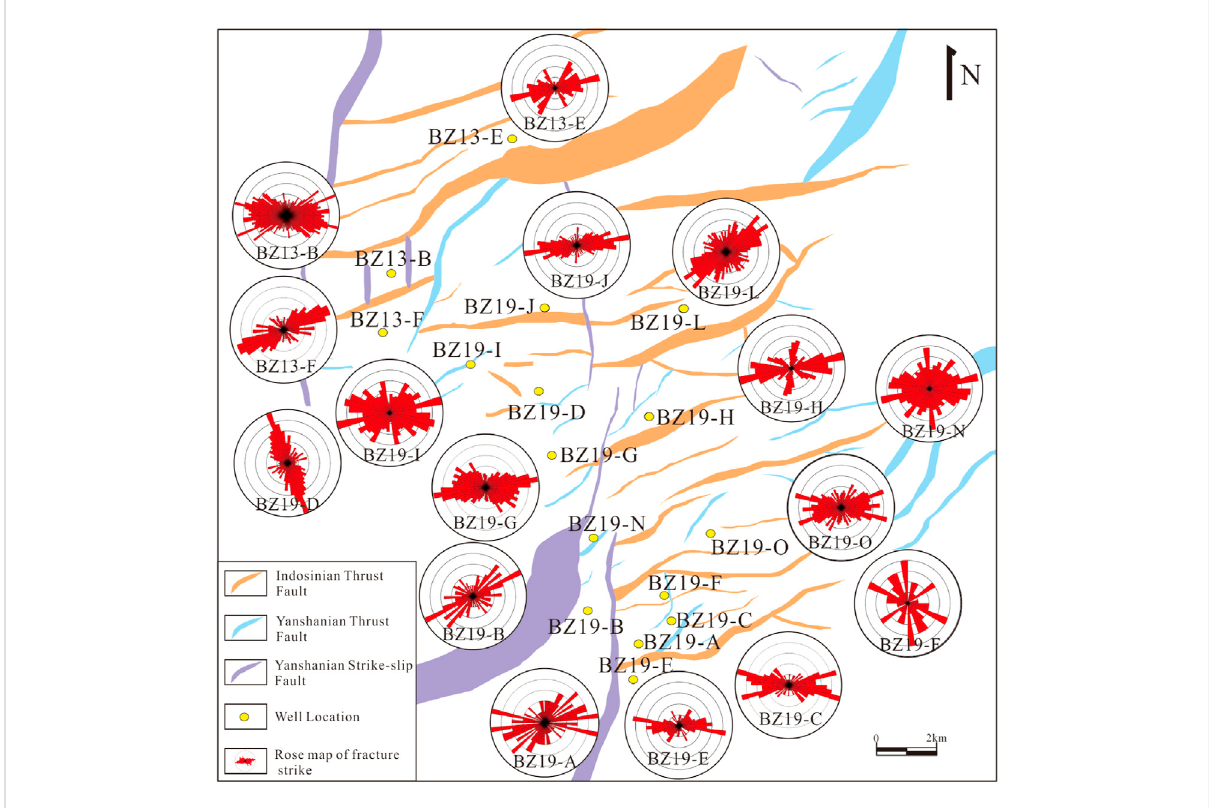
FIGURE 9 Directions of faults and fractures in the metamorphic rocks of the study area. The faults shown in this fi gure are the larger major faults in the study area. Fault data are modi fi ed from Xue et al., 2021 and fracture orientations are derived from the imaging logs of 16 wells.